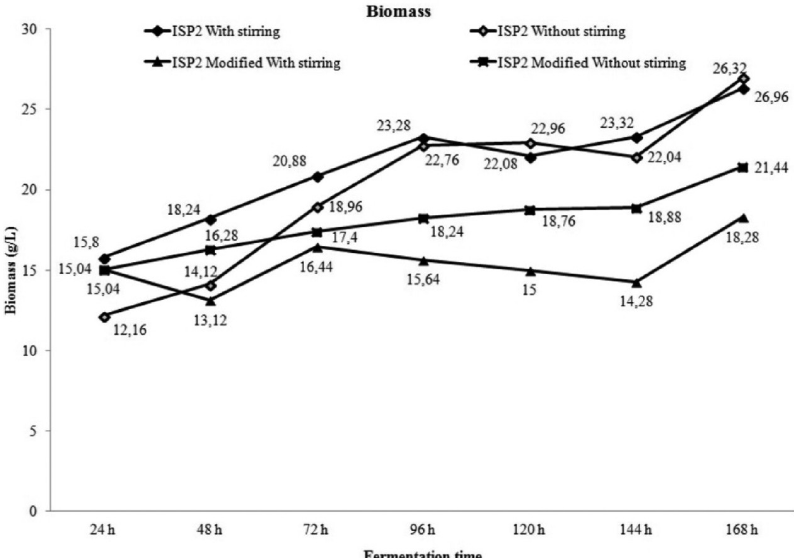
FIGURE 3 - Growth of biomass vs time in different fermentation